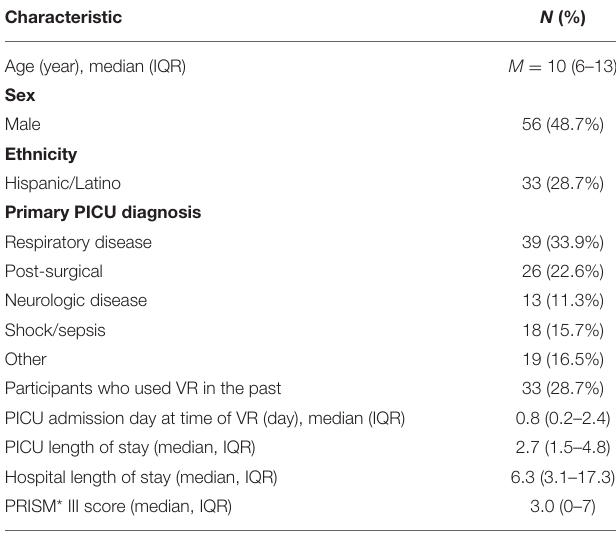
TABLE 1 | Demographic and clinical characteristics of study population ( N =